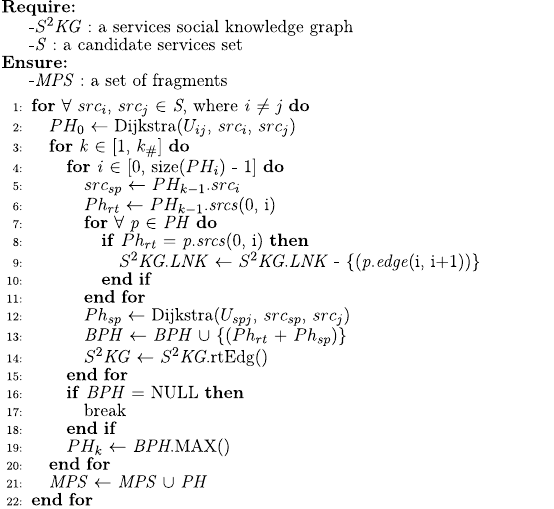
Algorithm 5. CFDY: Crossing-work fl ow fragment